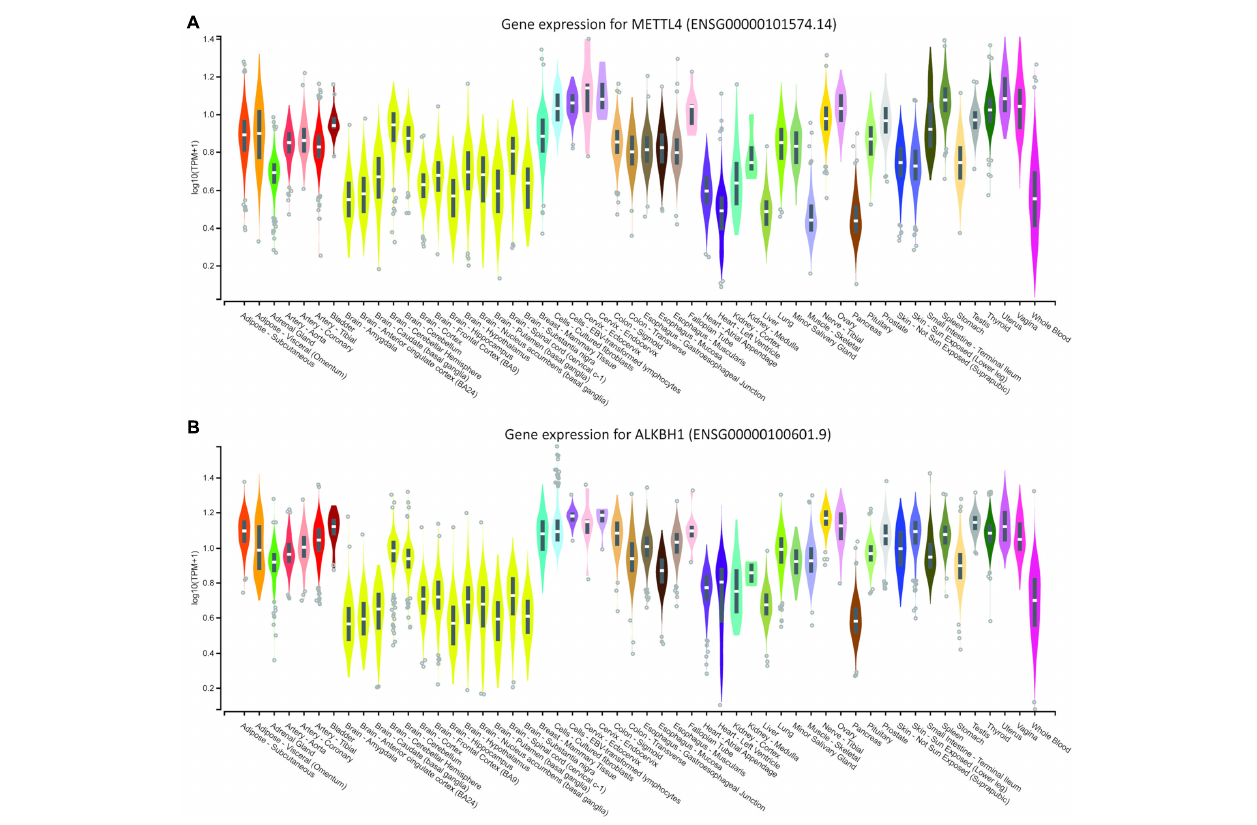
FIGURE 2 | Genotype-Tissue Expression data for (A) human METLL4 methyltransferase and (B) ALKBH1 demethylase. Data were downloaded from the GTEX portal on August 19th, (dbGaP Accession phs000424.v8.p2, 19/08/2020).